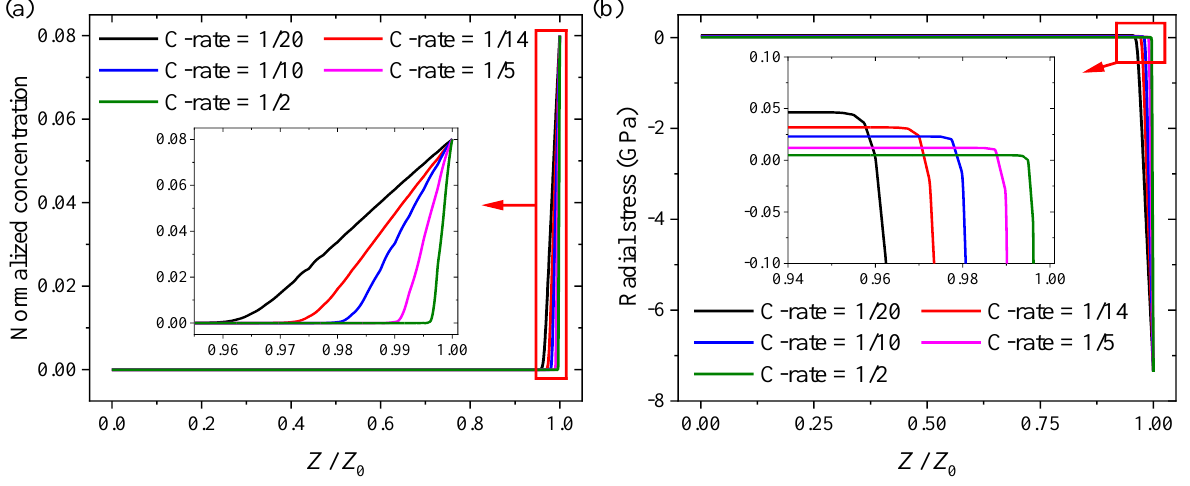
Figure 7. Spatial variations of ( a ) normalized Li concentration, and ( b ) radial stress along the thickness direction at the axisymmetric axis under different total C-rates at the end of stage 0.